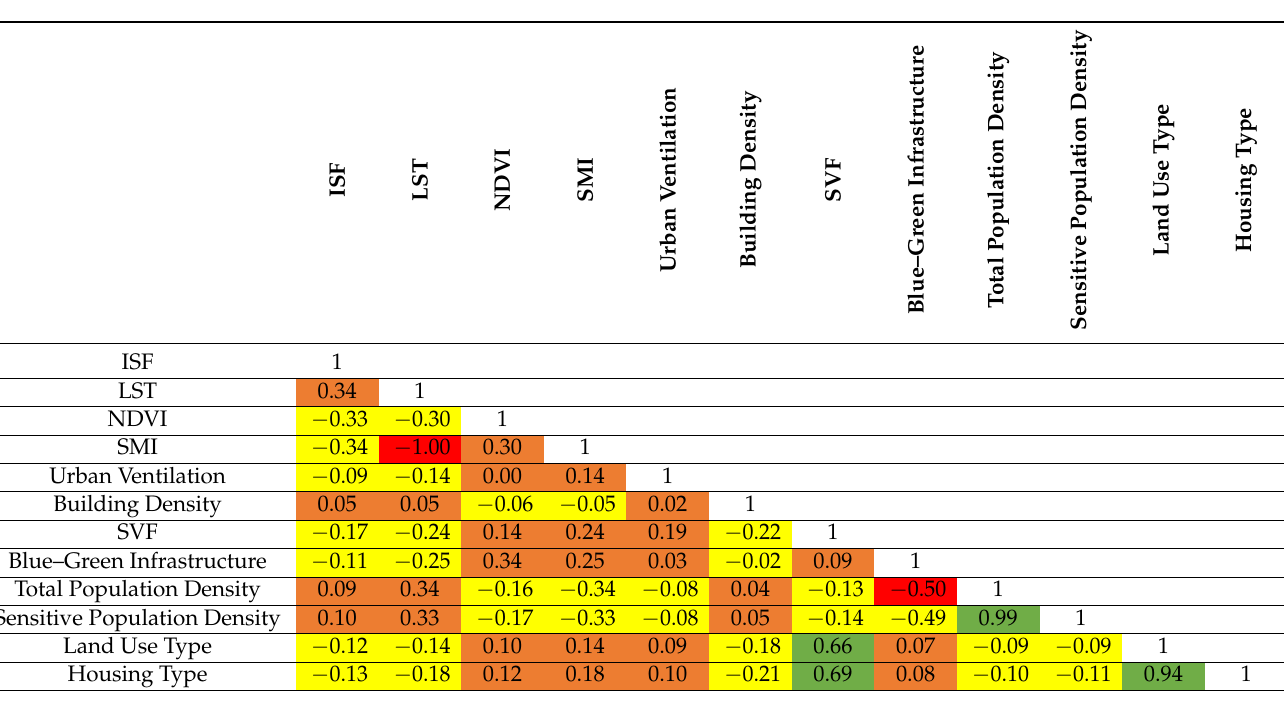
Table 13. Spatial correlation of selected